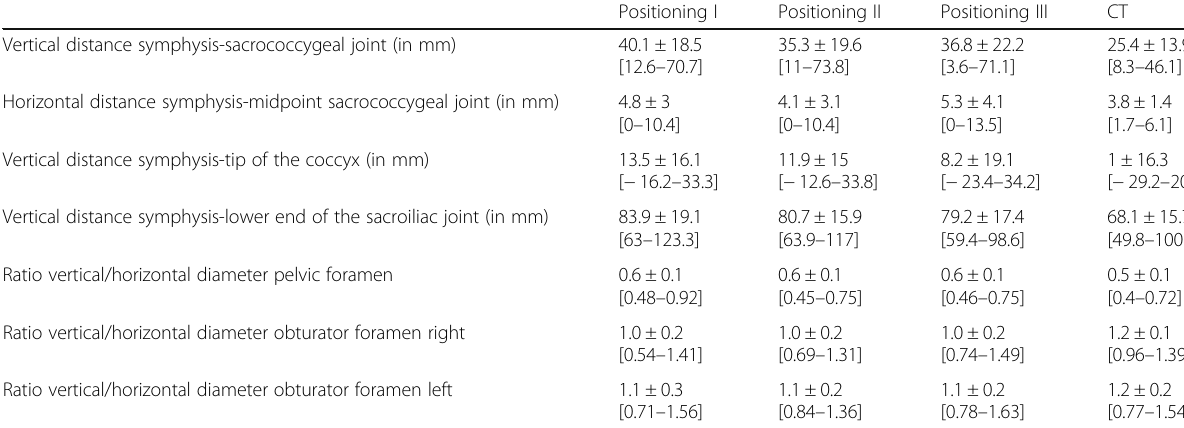
Table 1 Descriptive statistics: mean value ± standard deviation [min −